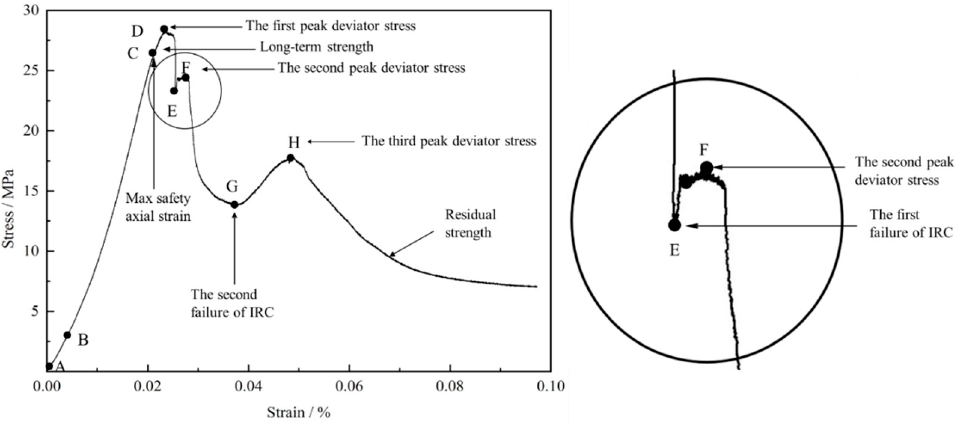
Figure 12. Complete stress–strain curve of the CTB-RC specimen under the TSC test.